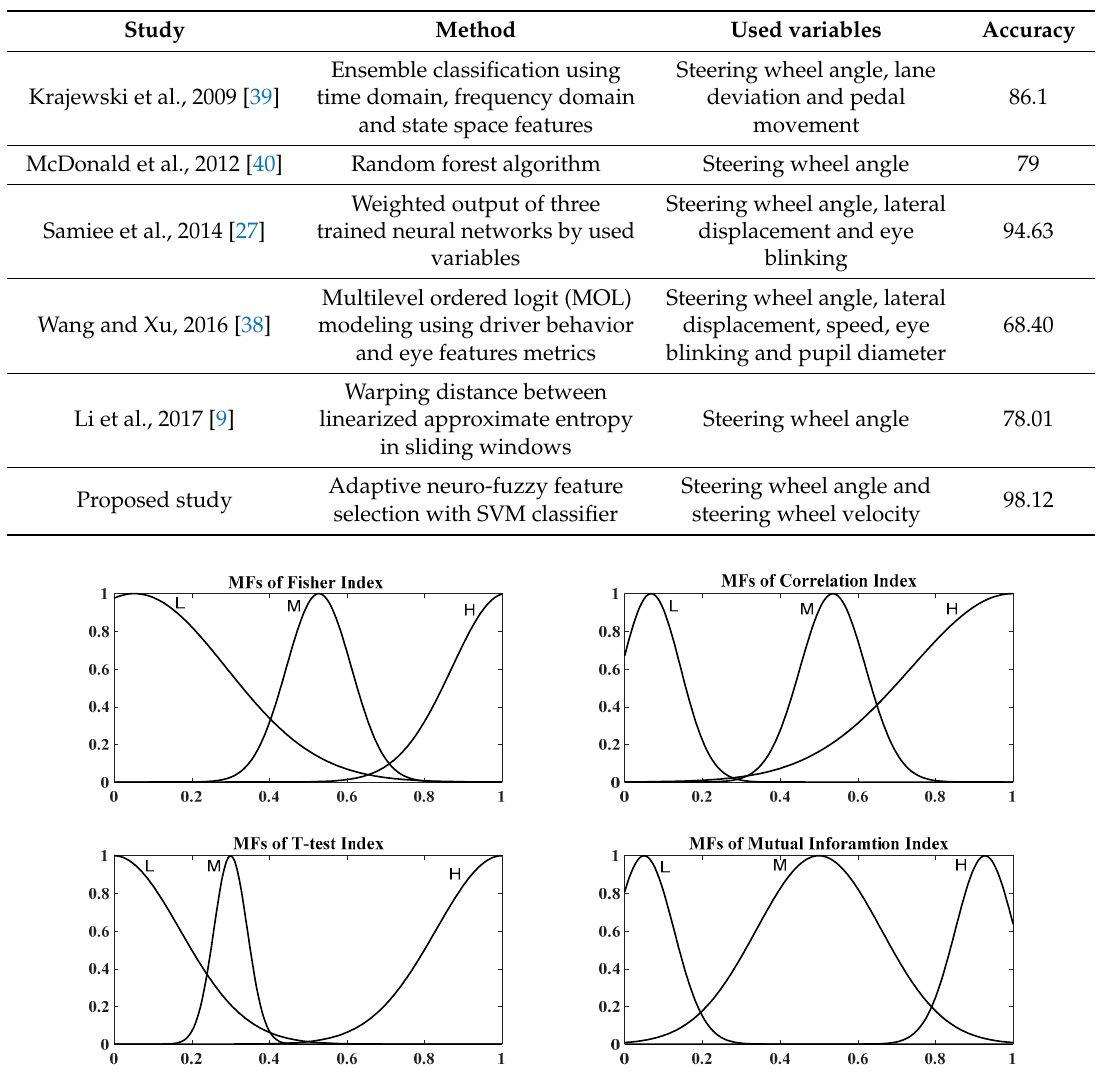
Table 6. Comparison the accuracy of the proposed method with the reported results of non-invasive drowsiness detection system in previous studies.